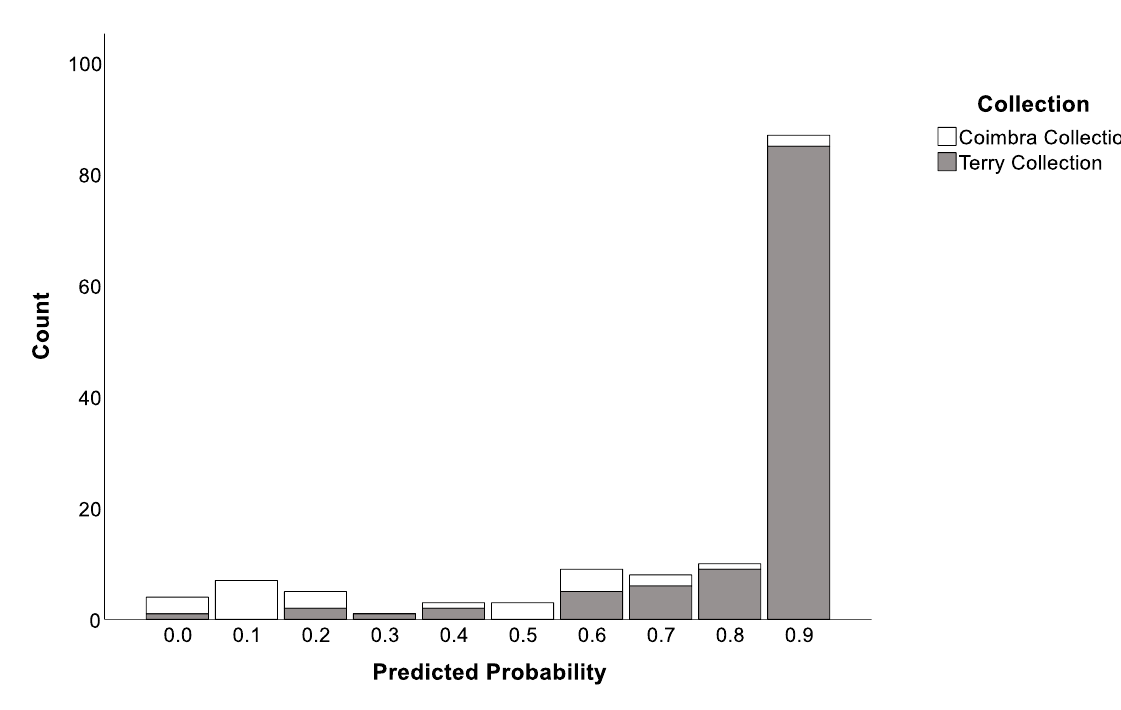
Figure 3. Distribution of p -values for the all-sexes Terry collection sample (n = 111) and the smallest all- sexes Coimbra collection subsamples (n = 26) that met the minimum 50% allocation accuracy